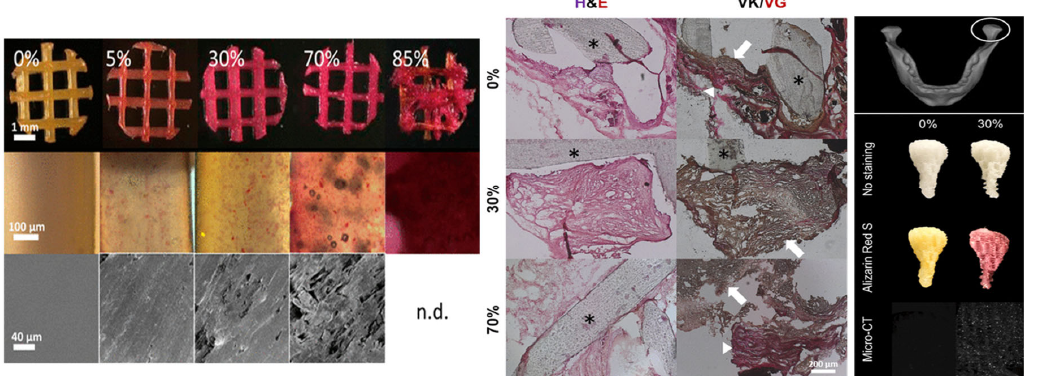
Figure 12. 3D-printed hybrid scaffolds. Top view depicting positively stained scaffolds for Alizarin Red S in all cases except pure polycaprolactone case. Middle image showing magnified images of stained scaffold struts describing the punctate stain of the mineralized particles within the PCL. Bottom view showing SEM of strut surfaces displaying rougher surface topographies in the more concentrated hybrid scaffolds. Histological studies of excised constructs. Cellularity under H & E stain (left) as well as bone (black/dark brown) and osteoid (red) formation under the von Kossa and van Gieson stains (right) is obvious. Asterisks represent scaffold struts. In the von Kossa and van Gieson stains, note the presence of both osteoid (red, arrowheads) and mineralized tissue